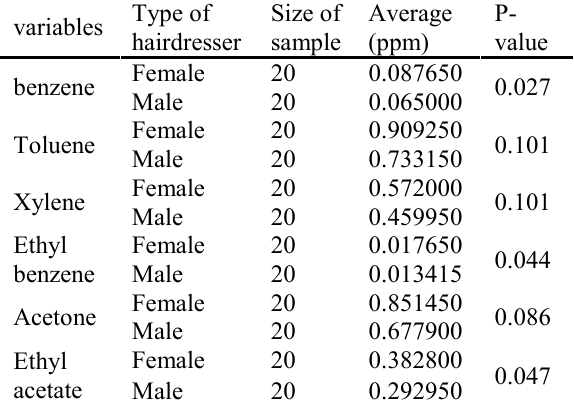
Table 5. Effect of ventilation type on the concentration of volatile organic compounds